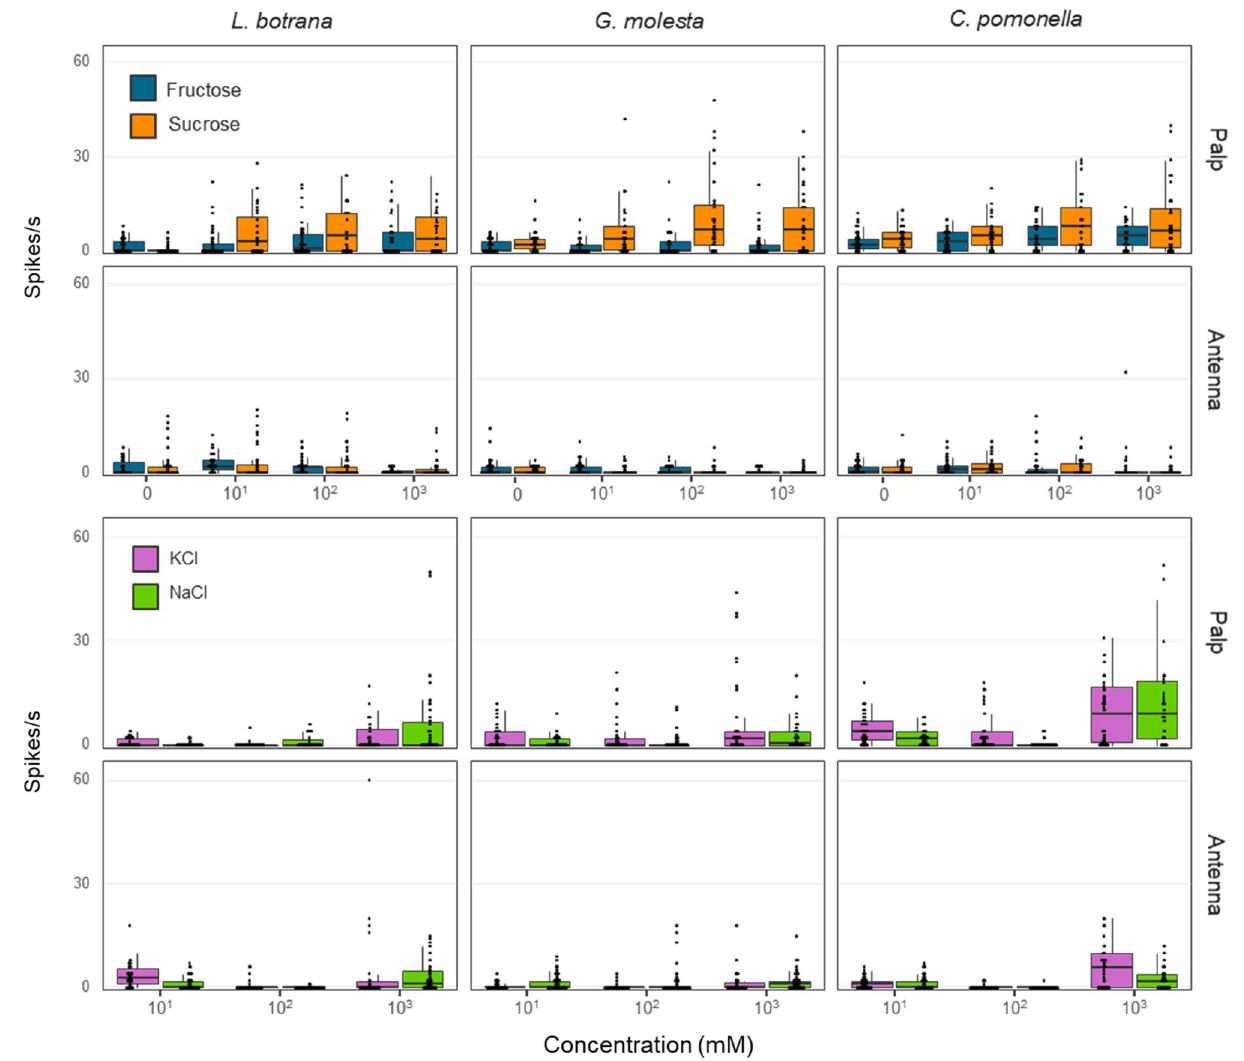
Figure 3. Response of gustatory receptor neurons of sensilla chaetica located on the apical segment of the labial palps and antenna of three tortricid moth species upon a 2 s stimulation with three doses of NaCl, KCl, fructose or sucrose. N = 16–34 sensilla of 4–6 individuals of each sex. Males and females have been combined in this plot. Box plots show median (horizontal line), first and third quartile (box), 1.5*inter-quartile range (error bars), and data points